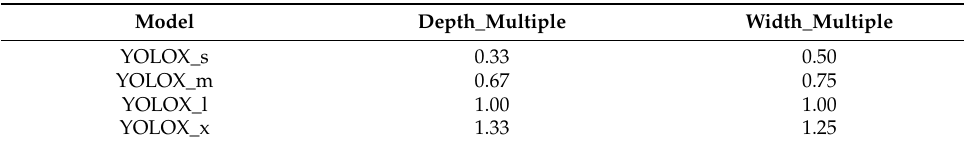
Table 1. Parameters of the YOLOX network for different